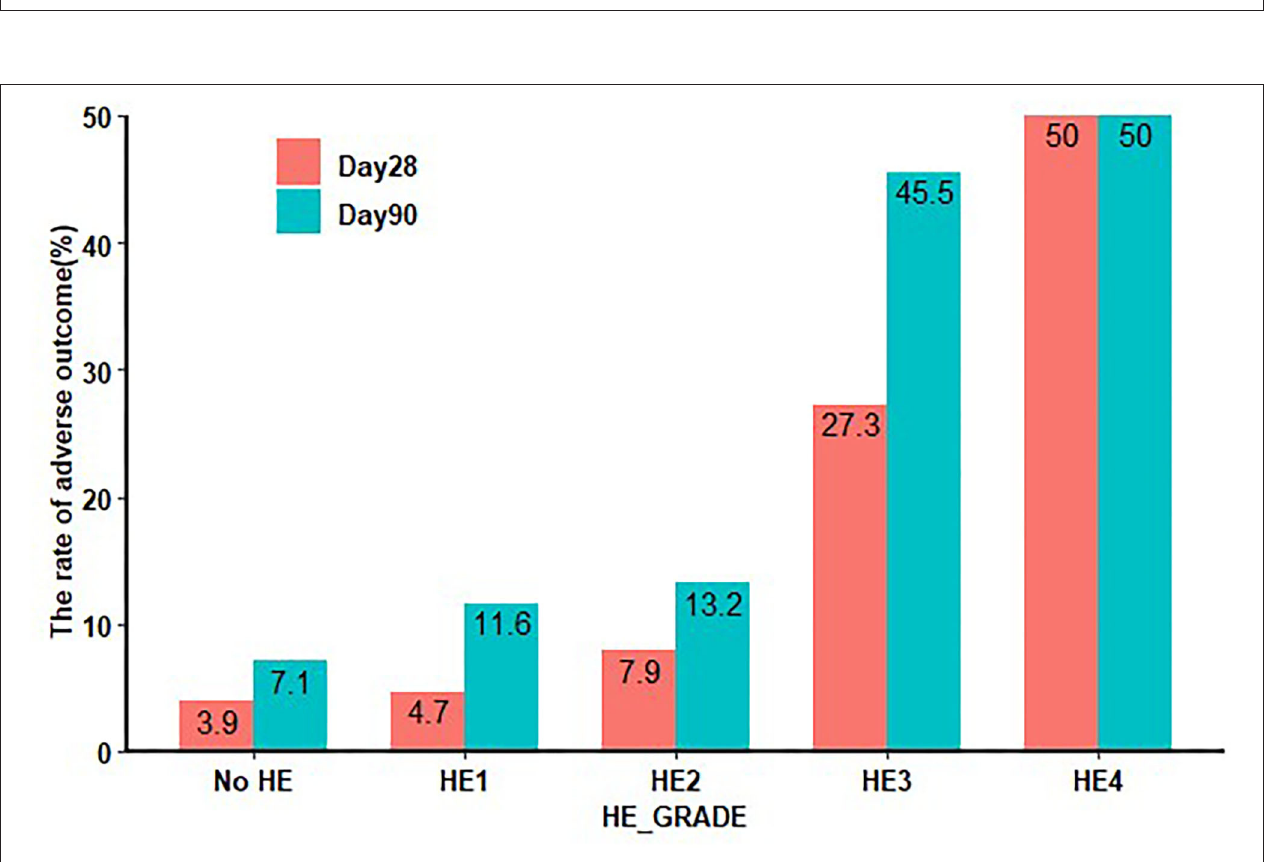
FIGURE 4 | Twenty-eight-day and 90-day clinical adverse outcomes in HE excluding other organ failure. HE: TB level < 12 mg/dL, INR < 1.5, CR < 2 mg/dL, without respiratory failure. HE, hepatic encephalopathy; TB, total bilirubin; INR, international normalized ratio; CR, creatinine.